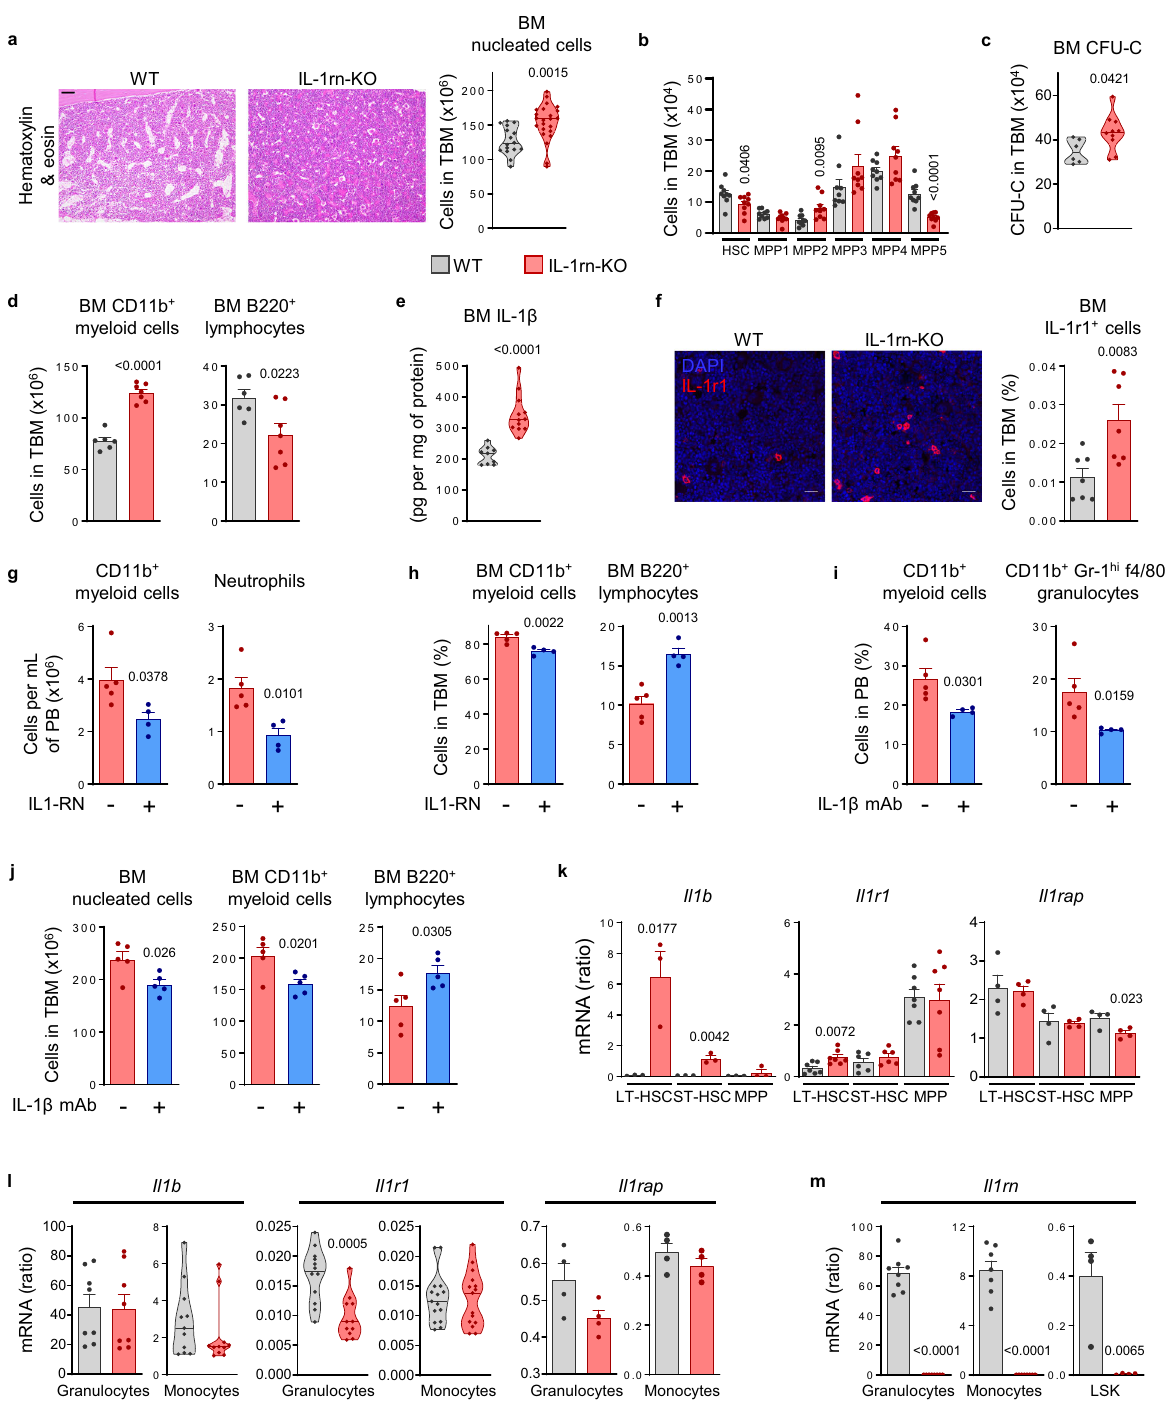
Identi fi cation of the sources of IL-1 β and IL-1rn in the bone marrow at the single-cell level To provide further insights into the main sources of IL-1 β and IL-1rn in the mouse BM at the single-cell level, we performed single-cell (sc) RNA-Seq and RNA fl uorescent in situ hybridization (FISH) in sorted cells. After integrating the WT and IL-1rn-KO scRNA-Seq data from FACS-sorted CD11b + cells by the Canonical Cross-correlation Analysis (CCA) algorithm of Seurat, unbiased cell clustering analysis was per- formed (Fig. 5a). WT cells were then used for annotation according to ImmGen 37 followed by application of the maximum enrichment score ±0.02 to label the clusters 29 using the cell type signatures imported